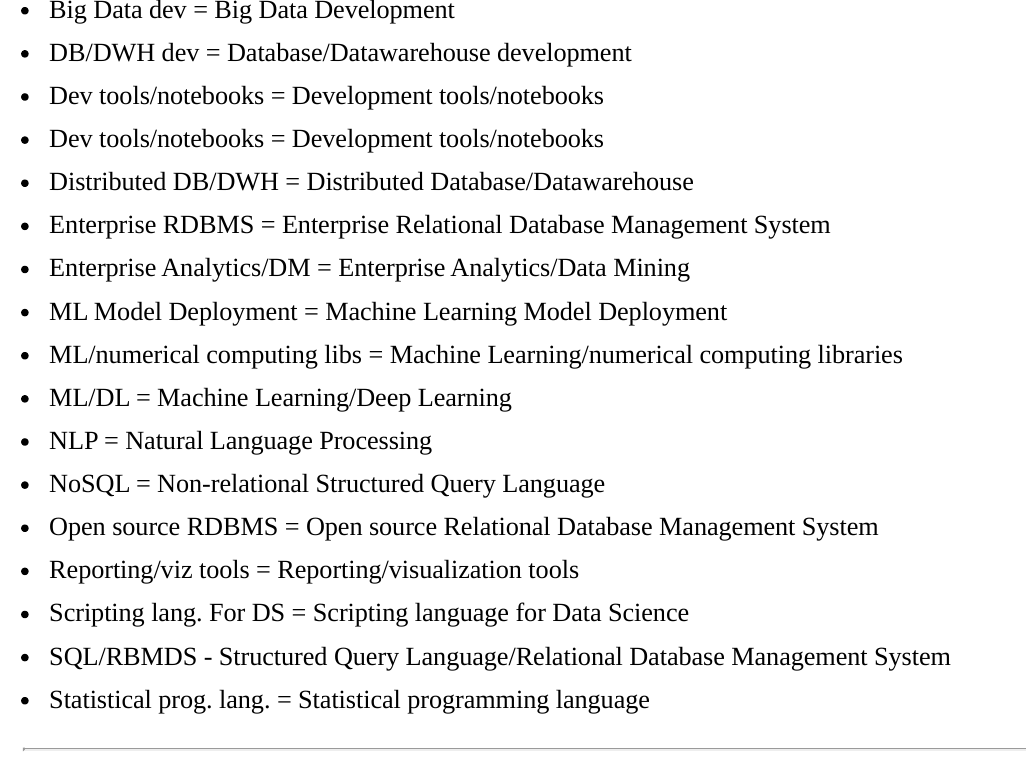
Figure 4. A summary of the questionnaire responses of the three subgroups of data